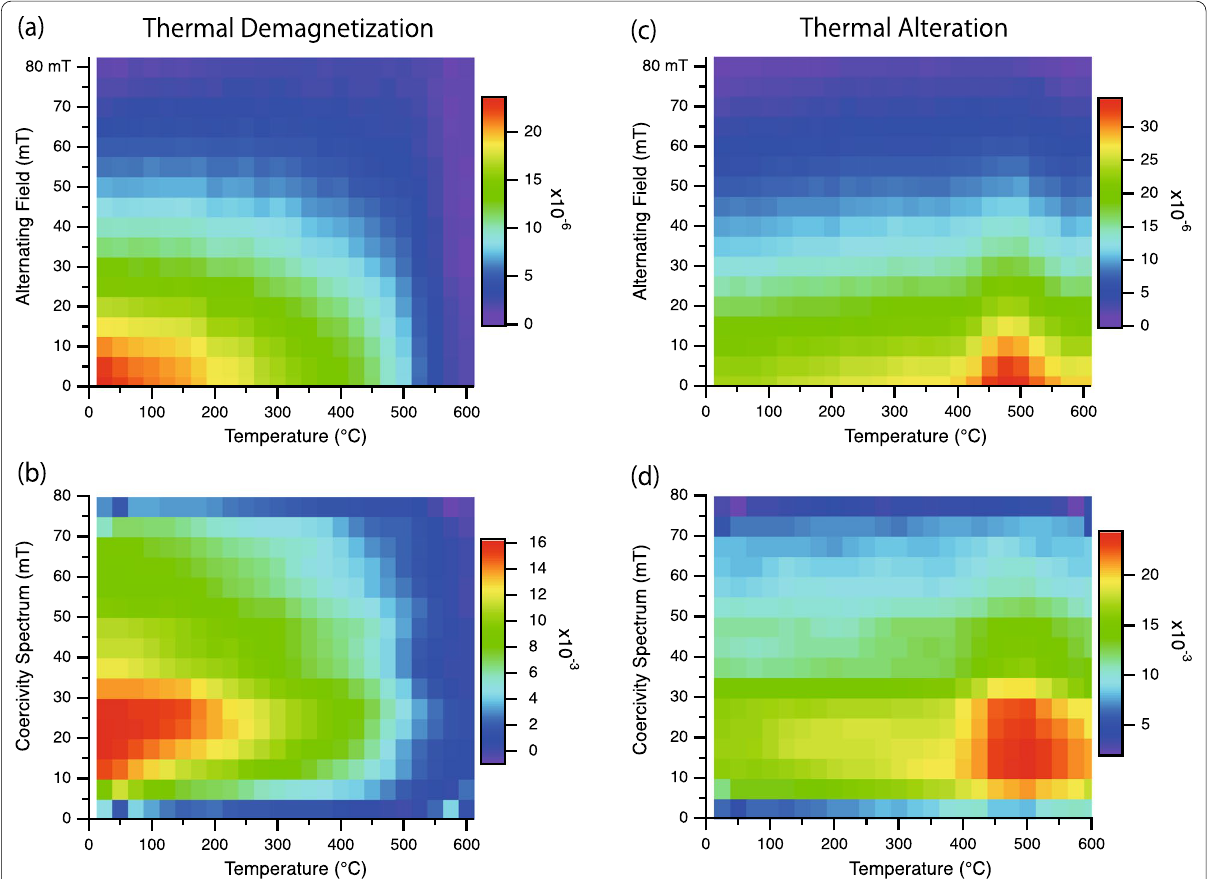
Fig. 10 Coercivity spectrums of ARM monitored during heating of sample 102-1Z-1-B. a The first ARM is acquired before each heating step, which is AF demagnetized and the magnetization is plotted with color for the corresponding temperature and field steps. b Coercivity spectrum of magnetization after each heating step is obtained by dividing the magnetization difference of successive AFD steps by the AFD step difference in a . c The second ARM is acquired and PAFD demagnetized up to 80 mT after removal of the first ARM by AFD up to 80 mT following each heating step, which is useful in identifying thermal alteration. d Coercivity spectrum of magnetization in c . ARM acquisition was conducted with DC field of 50 μT and AC field of 80